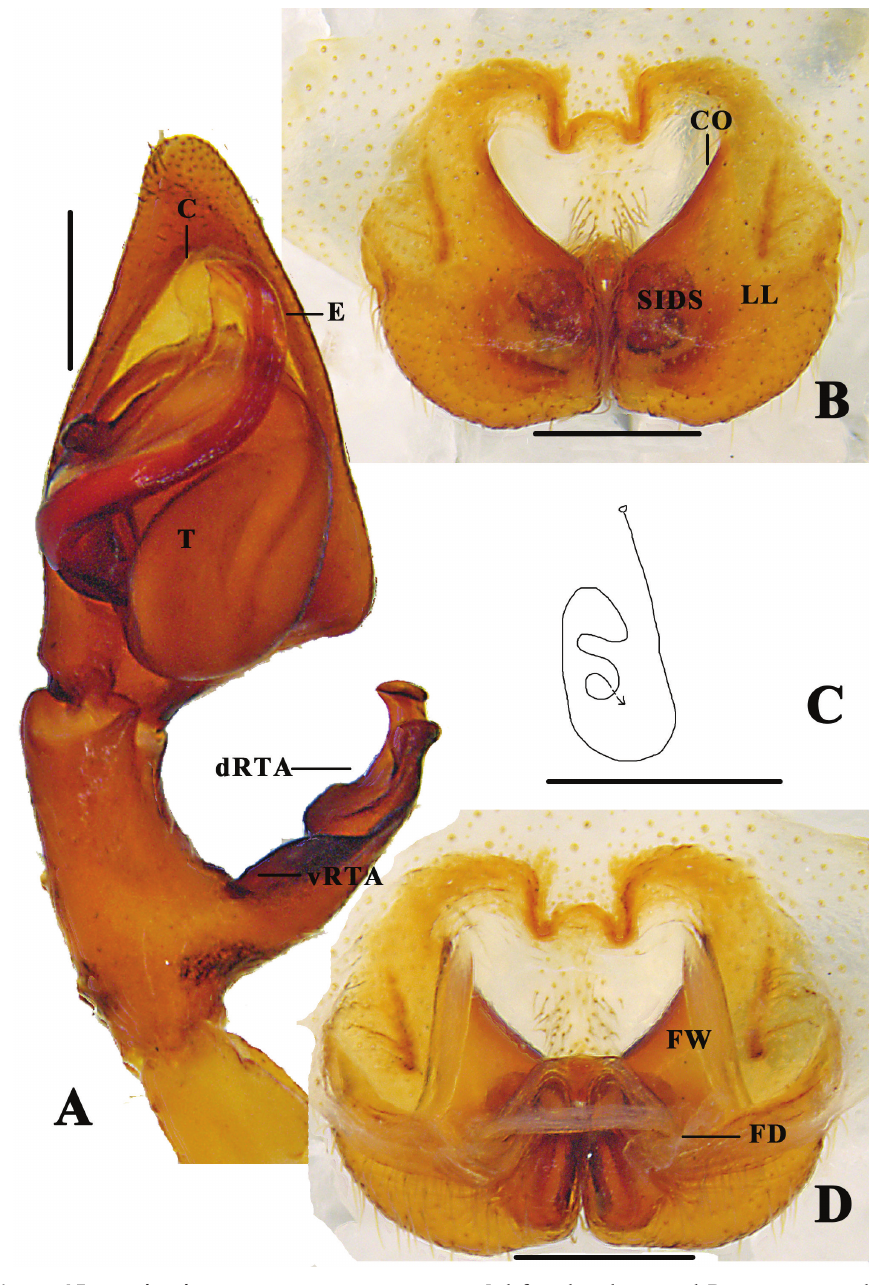
Figure 15. Pseudopoda yunnanensis Yang & Hu, 2001 A left male palp, ventral B epigyne, ventral C Schematic course of internal duct system in right part, dorsal D vulva, dorsal. Abbreviations: C–conduc- tor; dRTA–dorsal retrolateral tibial apophysis; E–embolus; vRTA–ventral retrolateral tibial apophysis; T–tegulum; CO–copulatory opening; LL–lateral lobes; FD–fertilisation duct; FW–first winding; SIDS– sclerotised internal duct system. Scale bars: 0.5